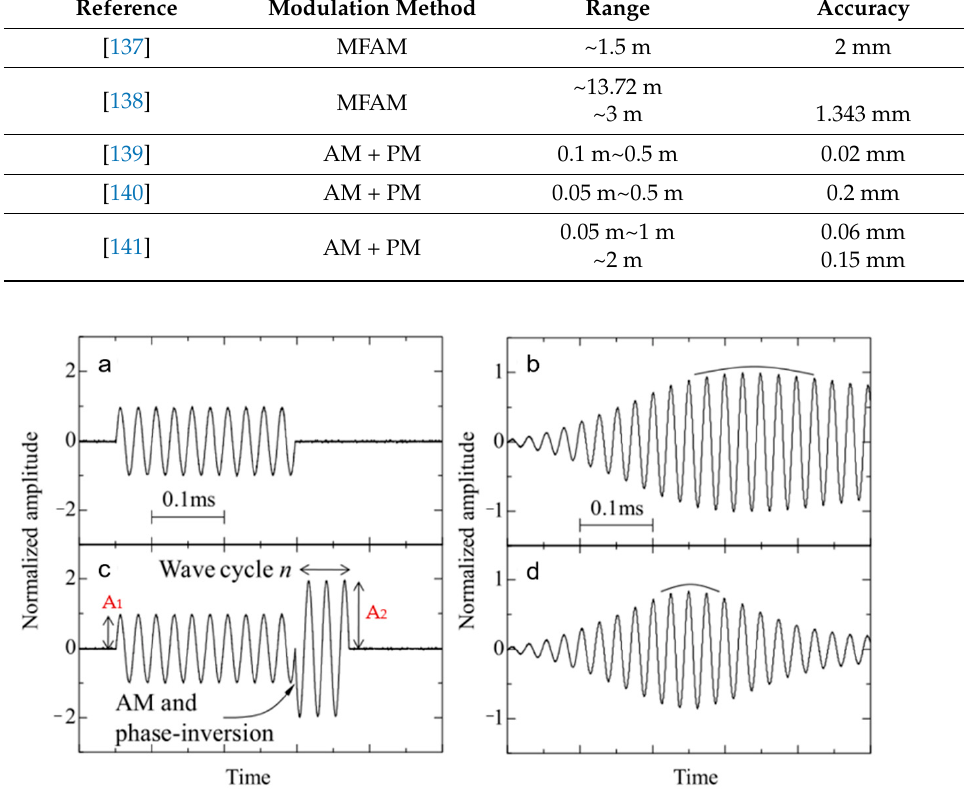
Figure 18. Ultrasonic waveform ( a ) Conventional driving signal and ( b ) its received waveform. ( c ) AMPI driving signal and ( d ) its received waveform [139].